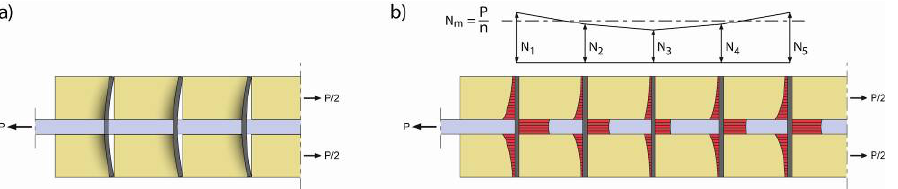
Figure 5: Resilient connection between wood and PMMA.